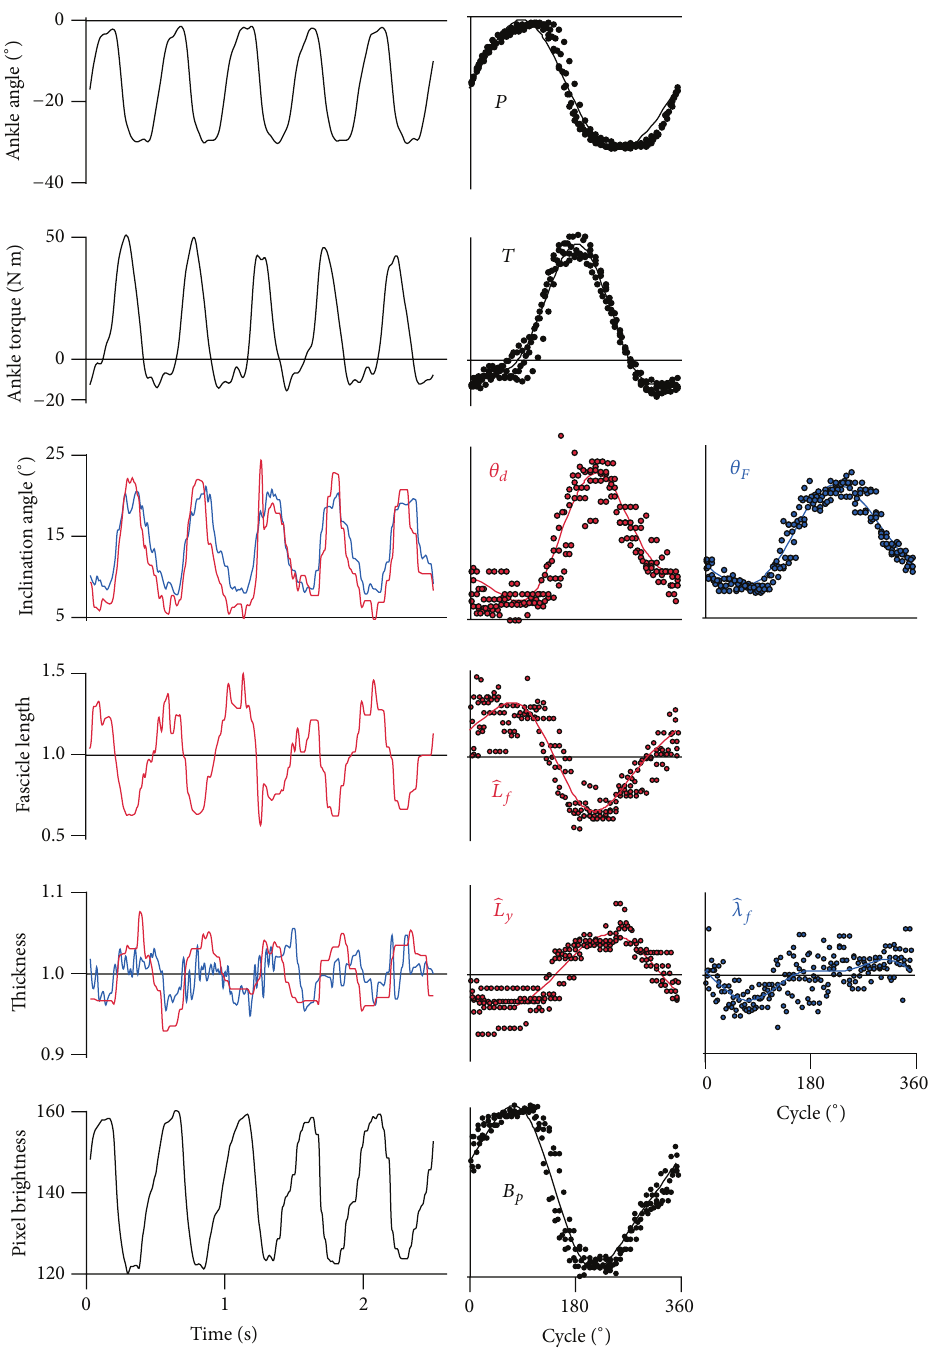
Figure 2: Muscle Structural Data for the Lateral Gastrocnemius during One Set of Ankle Plantarflexions . The first column shows the parameters changing over five contraction cycles. The middle and right columns show these data expressed as a percentage of the contraction cycle and show individual points as well as the smooth model calculated from Fourier series. Parameters determined from manual digitization are shown in red, and parameters determined following the discrete Fourier transform are shown in blue.